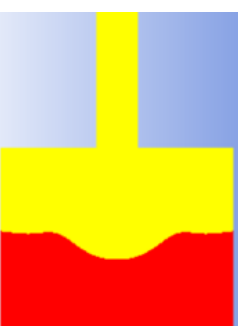
Figure 7. Numerical simulation results of the the gas jet forming.